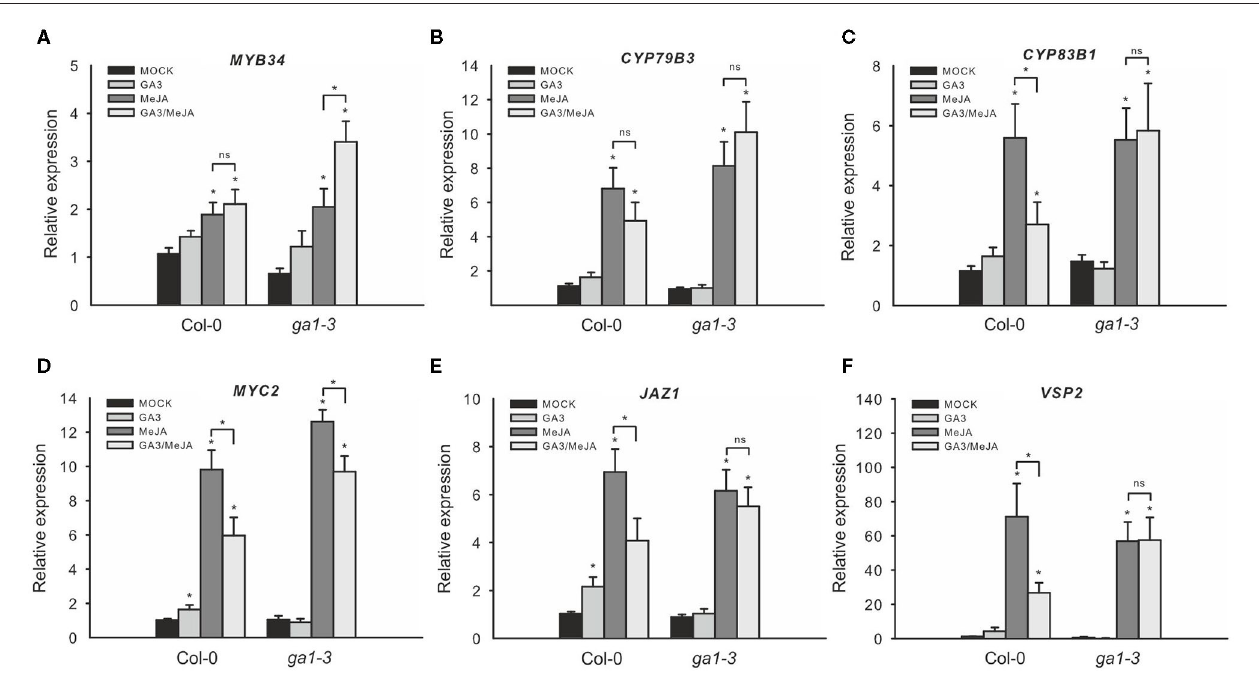
FIGURE 5 | Combined GA/JA treatment does not decrease IG biosynthesis gene expression in the ga1–3 mutant. The effect of combined GA/JA treatment on gene expression in the DELLA-accumulating mutant ga1–3 was tested in 6-week-old plants sprayed with MOCK, 50 µ M GA 3 , 50 µ M MeJA, or 50 µ M MeJA/50 µ M GA 3 treatments. MYB34 (A) , CYP79B3 (B) , and CYP83B1 (C) served as marker genes for IG biosynthesis, whereas MYC2 (D) , JAZ1 (E) , and VSP2 (F) served as marker genes for JA signaling. Data are means ± SE from three independent experiments with four biological replicates in each case ( n = 12). Values marked with asterisks differ significantly from the respective MOCK treatment (Student’s t -test; p < 0.05). Values in parentheses indicate direct comparisons (ns, not significantly different; asterisks mark significantly different values; Student’s t -test; p <